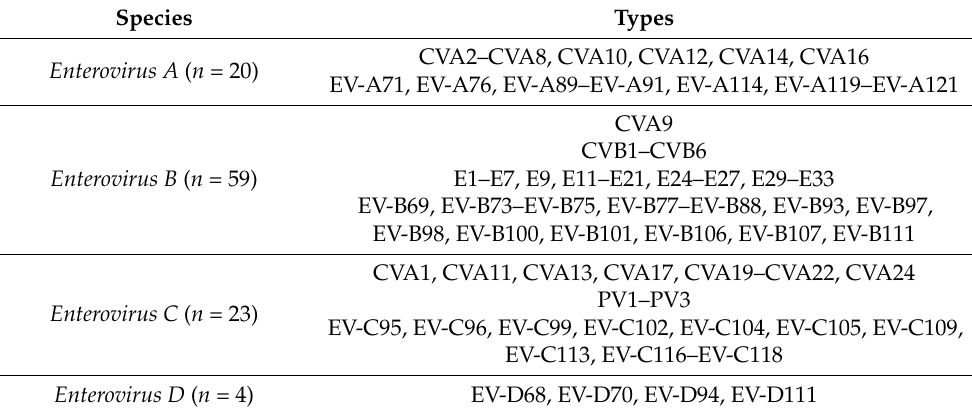
Table 1. Enterovirus types infecting humans by species [1]. CVA, Coxsackie A virus; CVB, Coxsackie B virus; EV, enterovirus; E, echovirus; PV, poliovirus. Species